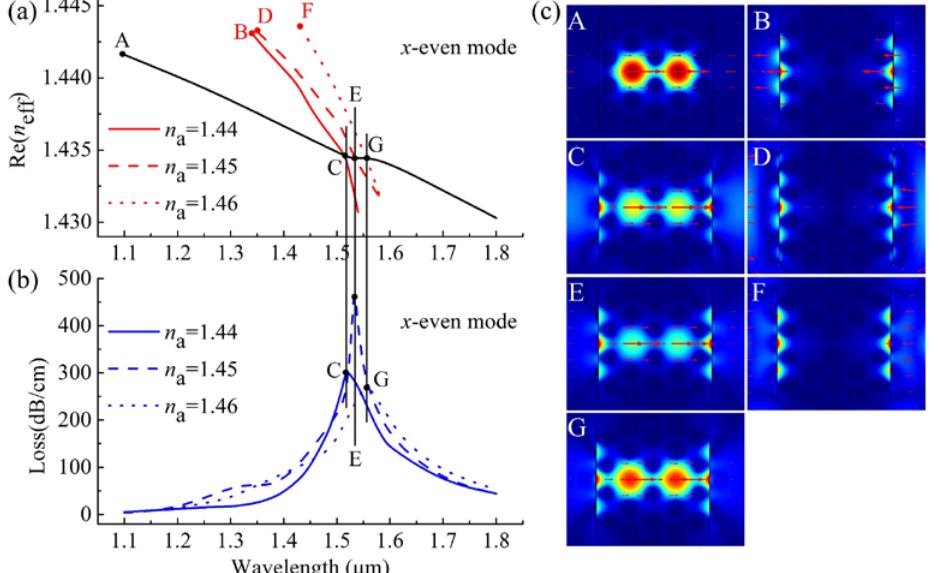
Figure 3. ( a ) The real parts of the effective refractive index (Re ( n eff )) curves of the x -even core modes (black lines) and the x -even SPP modes at n a = 1.44, 1.45, and 1.46 represented by the red solid, dashed, and dotted lines, respectively; ( b ) the loss spectra of the x -even core modes at n a = 1.44, 1.45, and 1.46 represented by the blue solid, dashed, and dotted lines, respectively; ( c ) electric field distributions of the x -even core mode A at 1100 nm, x -even SPP mode B at 1340 nm, and x -even core mode C at 1518 nm for n a = 1.44, electric field distributions of x -even SPP mode D at 1350 nm and x -even core mode E at 1533 nm for n a = 1.45, and electric field distributions of x -even SPP mode F at 1430 nm and x -even core mode G at 1556 nm for n a = 1.46.